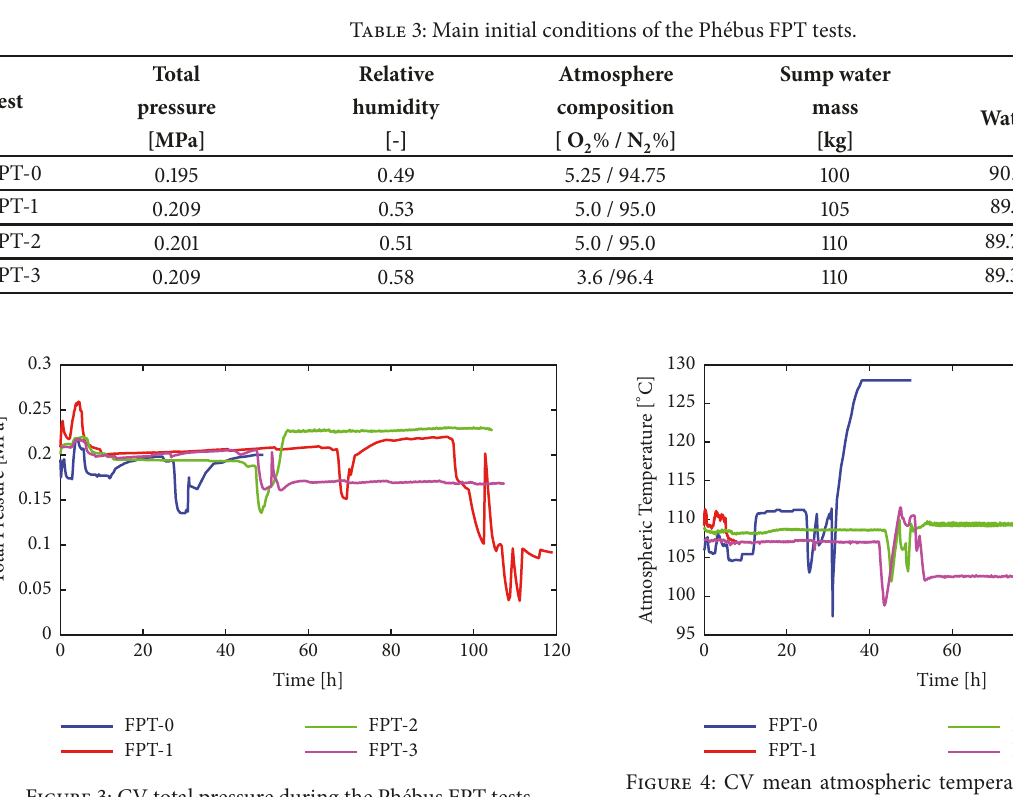
Figure 3: CV total pressure during the Ph´ebus FPT tests.